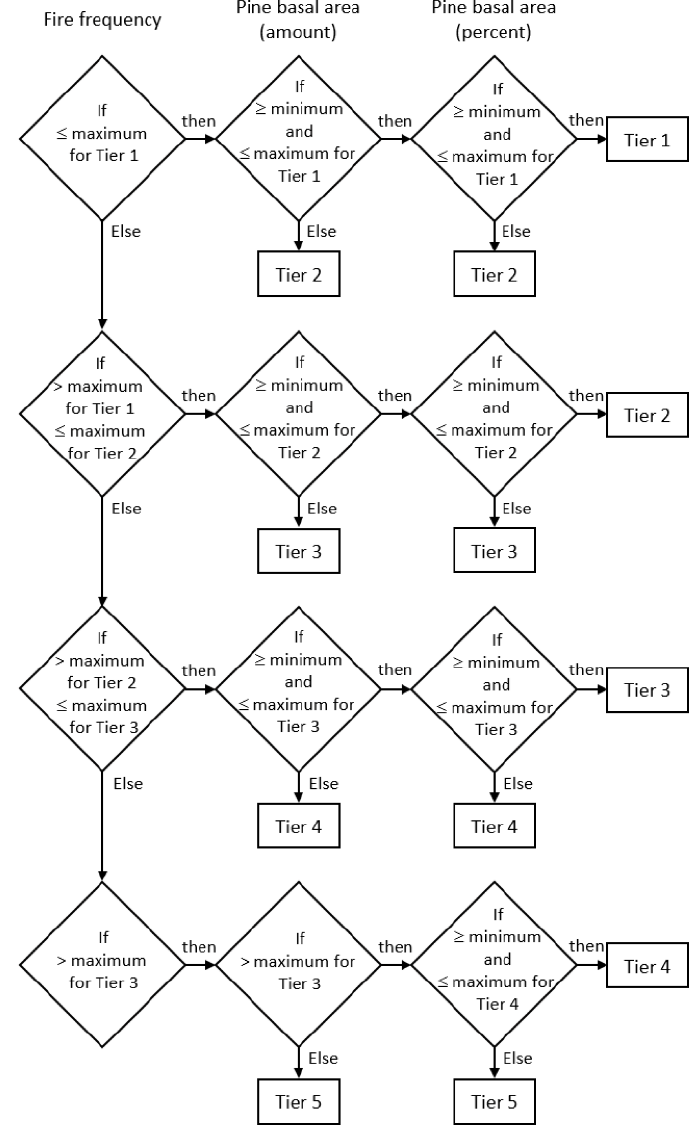
Figure 2. Logic model used to assign ecological condition class to each historically pine-dominated area of forest in the Talladega National Forest. Tier 6 is predominantly deciduous forest located in coves, along streams, and on steep north- and northwest-facing slopes.